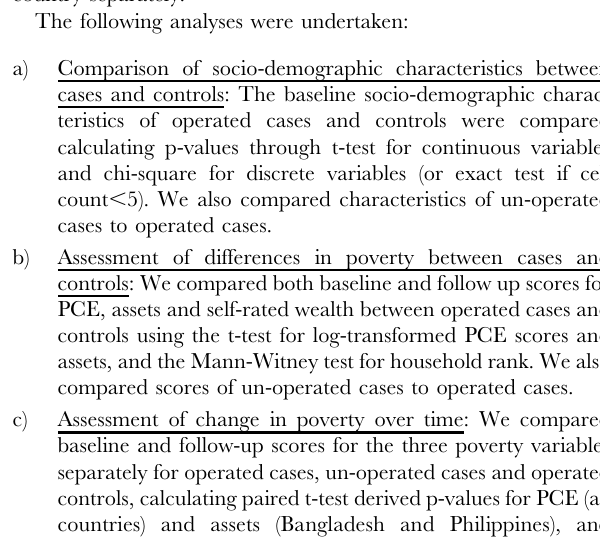
Table 1. Follow-up by country for operated cases, controls and un-operated cases.